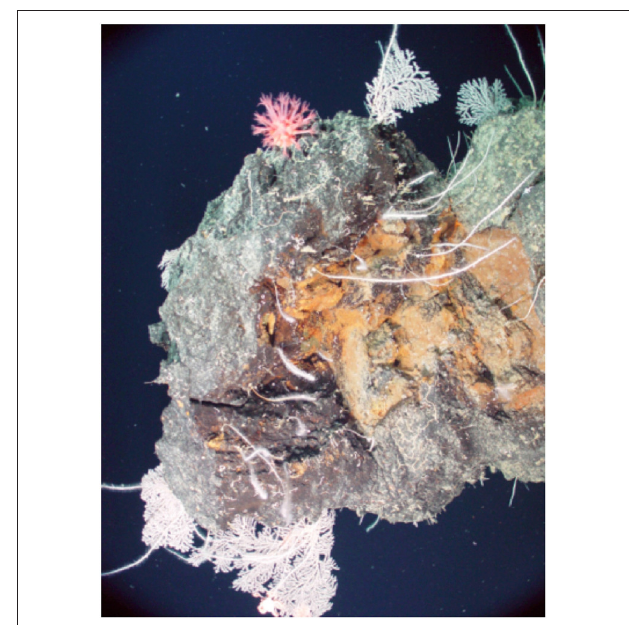
FIGURE 1 | Extinct chimney on Explorer Ridge with oxidizing sulfide, corals and